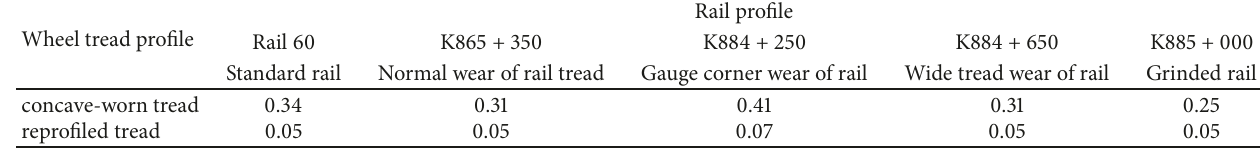
Table 2: The matching equivalent conicities between different worn rails and treads.